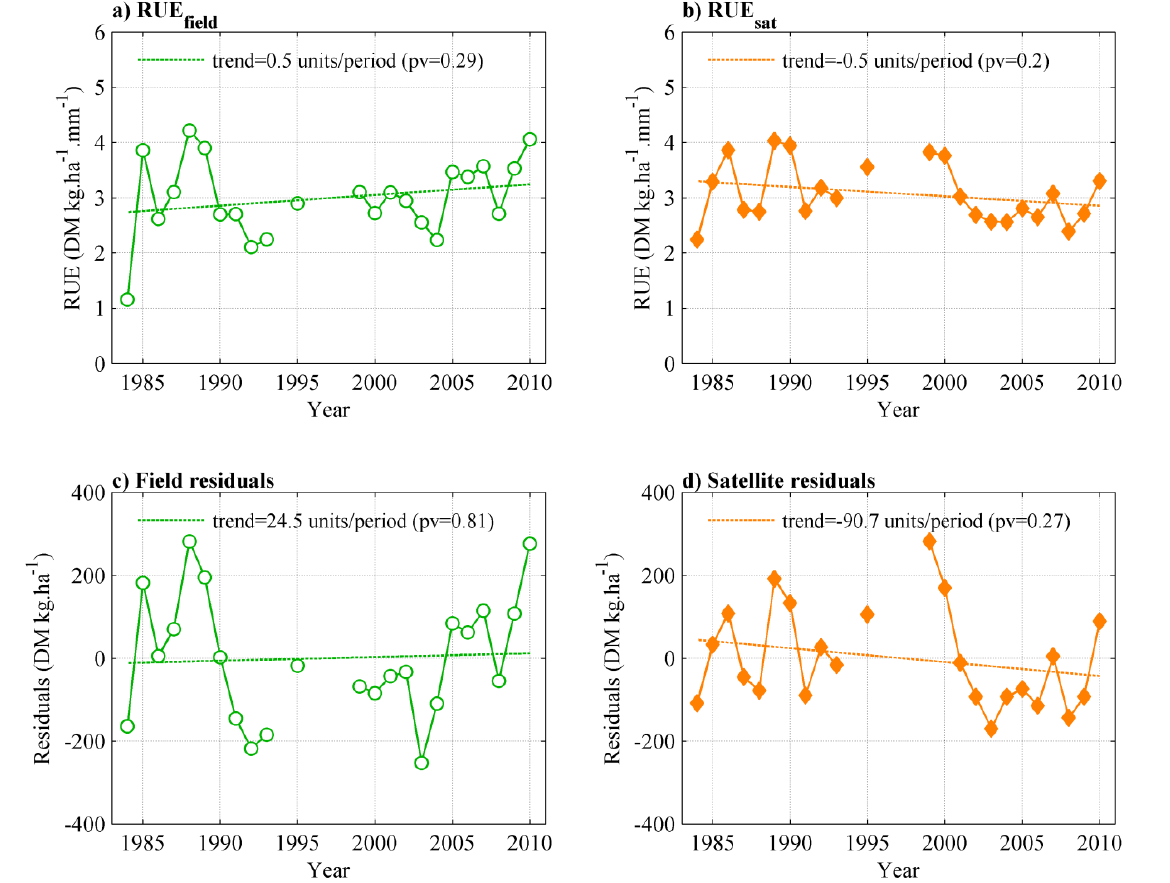
Figure 5. Time-series of RUE calculated with ( a ) field ANPP and ( b ) satellite estimates of ANPP. Time-series of ANPP residuals derived from ( c ) field ANPP and ( d ) satellite ANPP. Trends are not significant at the 95%